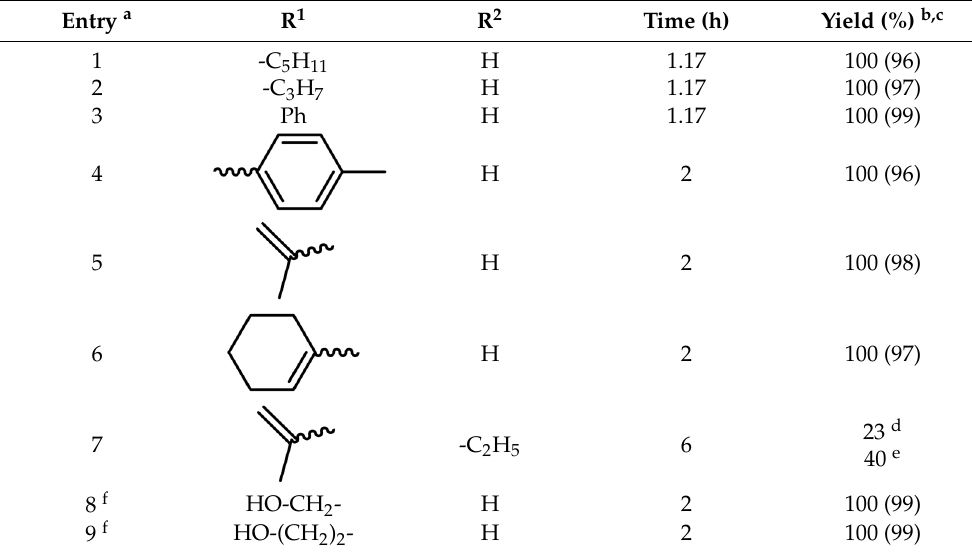
Table 17 . Hydration of terminal and internal alkynes promoted by complex 39 in water.